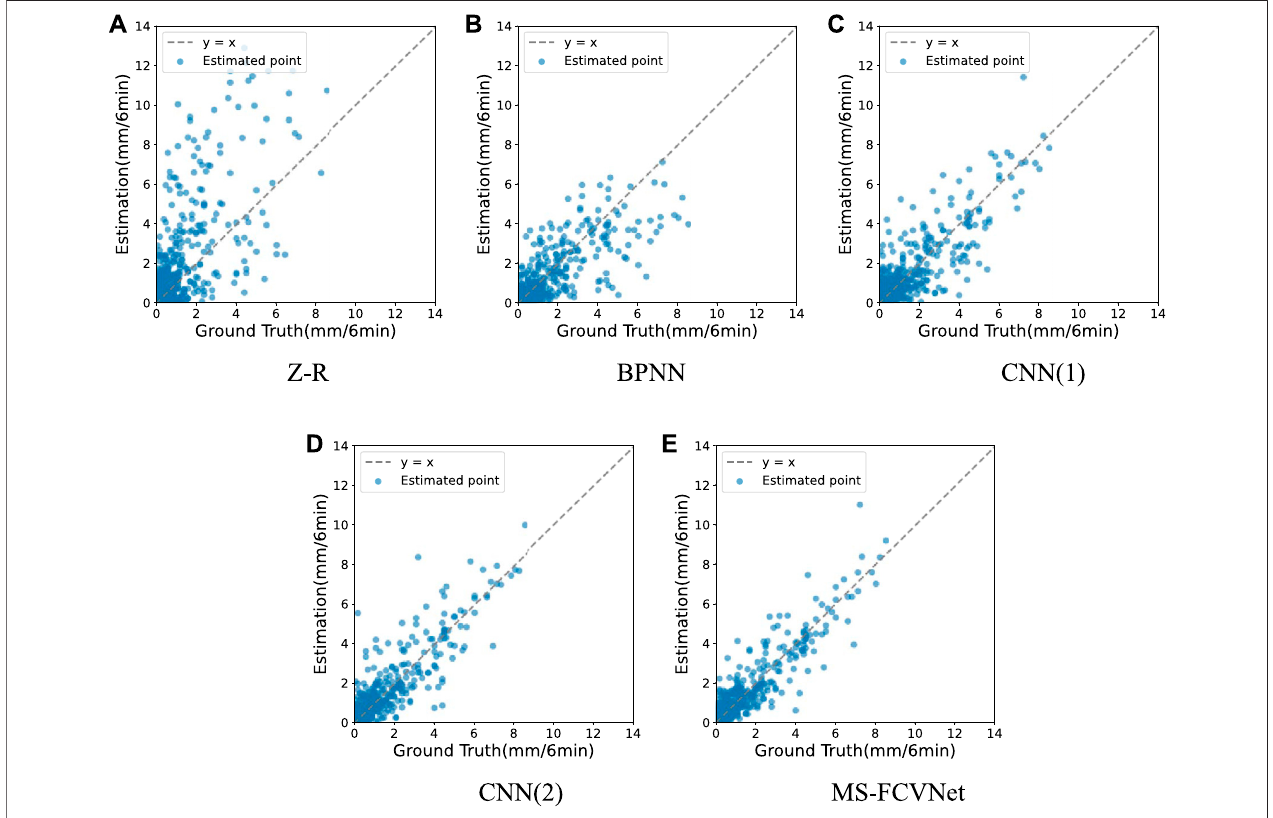
FIGURE 7 | Distribution of model (A) Z-R relationship, (B) BPNN, (C) CNN (1), (D) CNN (2) and (E) MS-FCVNet estimation in the test set relative to the ground truth value.